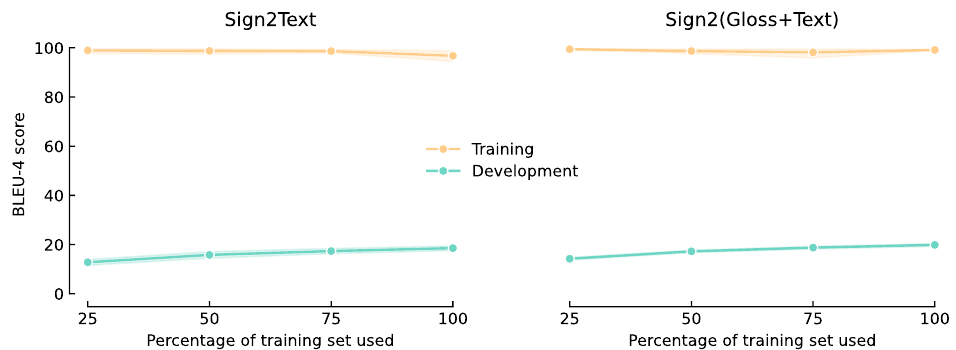
Figure 5. The learning curves for all Sign2Text models ( left ) and all Sign2(Gloss+Text) models ( right ) show clear overfitting. They also show that adding additional data would not yield large improvements to the BLEU-4 scores of the models.